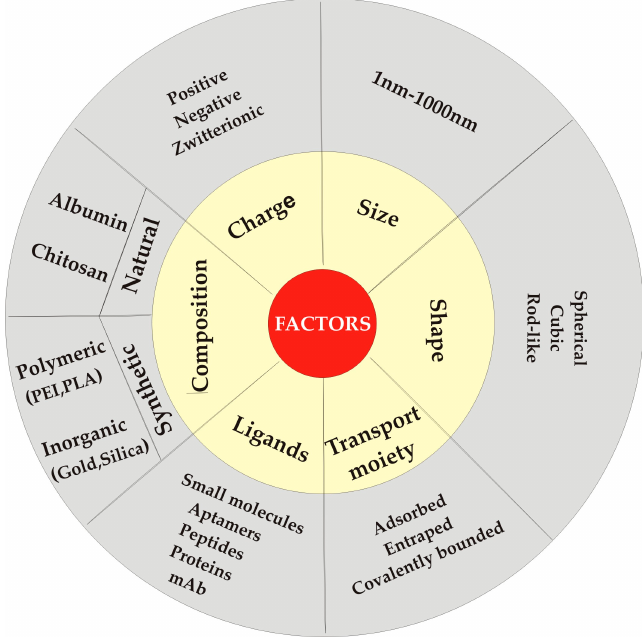
Figure 3. Factors influencing drug delivery from nanoparticles.